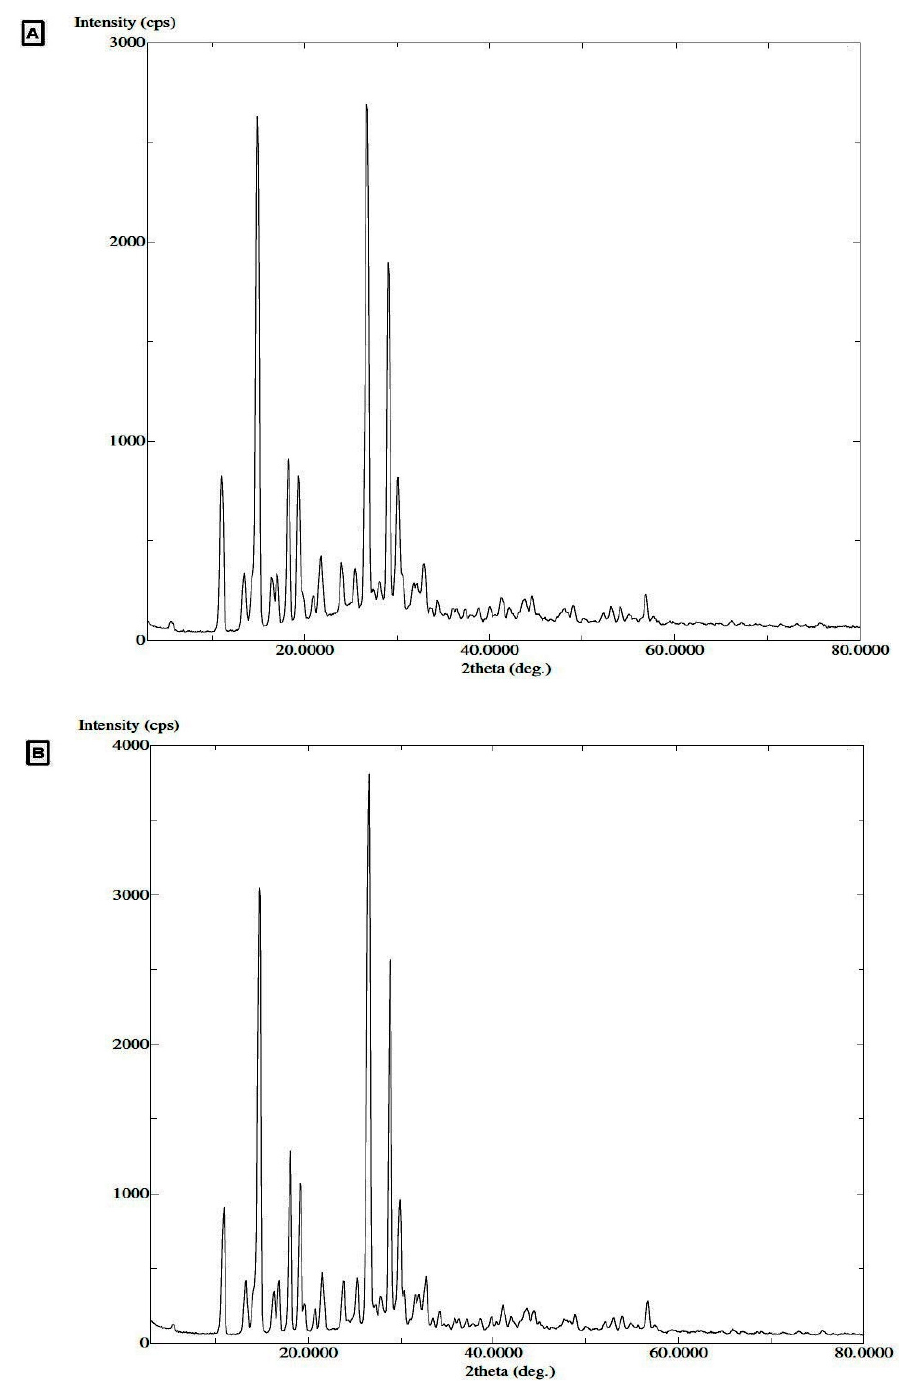
Figure 3. PXRD spectra of ( A ) TMZ, ( B ) TMZ equilibrated sample retrieved from H 2 O.